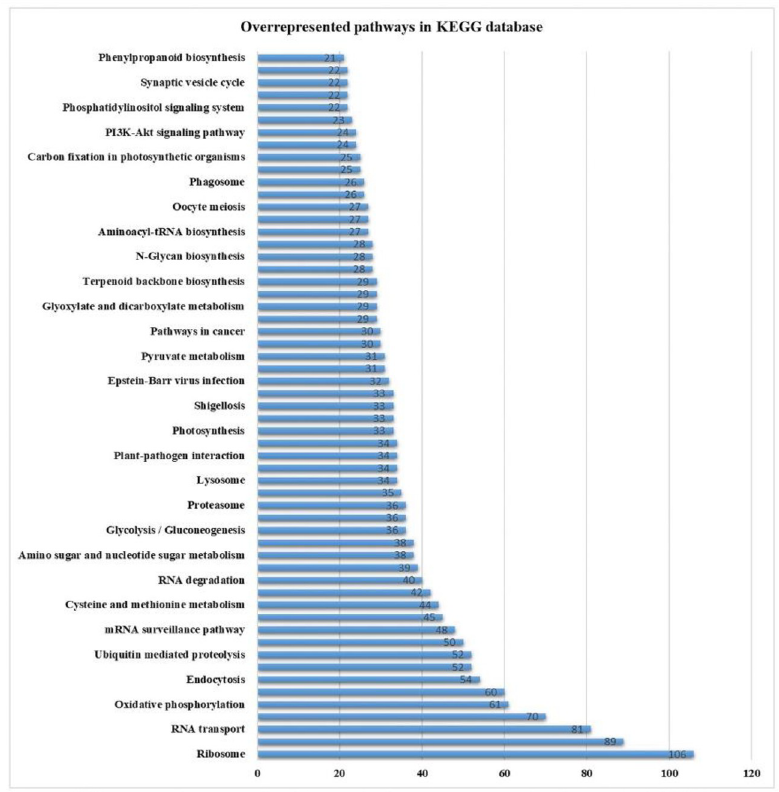
Fig 6. The transcriptome of L . tridentata in the overrepresented pathways in the KEGG database.